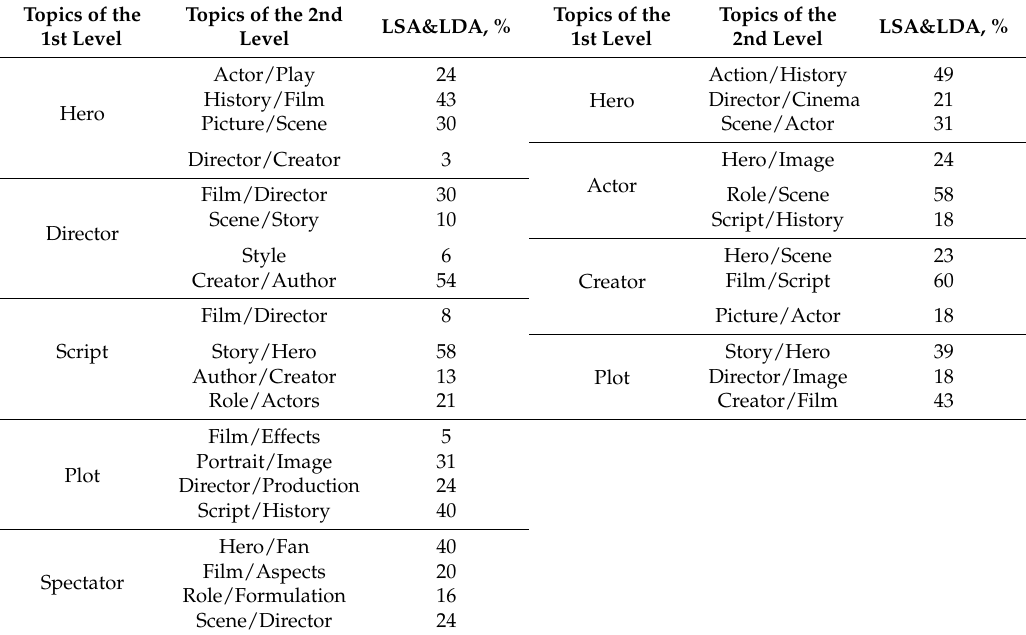
Table 11. Results of the Final Version of the Labels of the CF’s Semantic